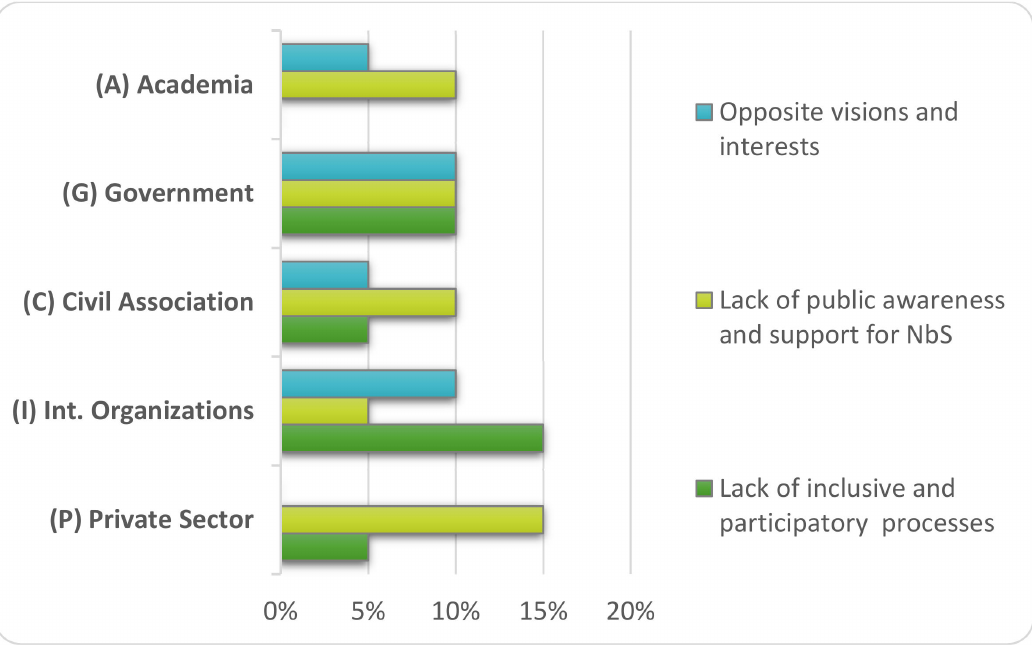
Figure 6. Social barriers perceived per group of stakeholders. Source: Authors